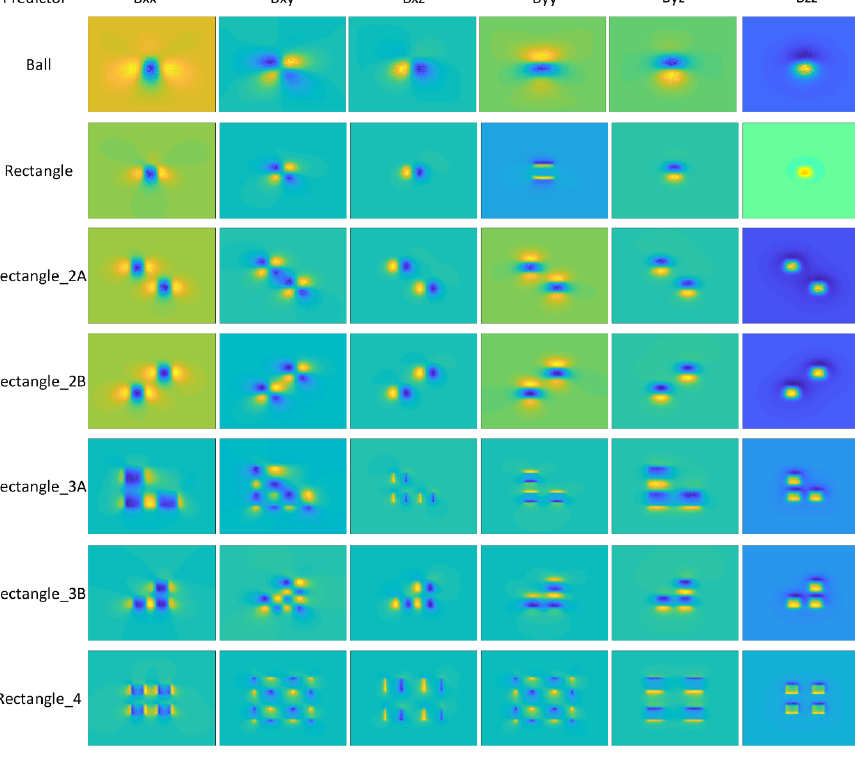
Figure 5. 2D images of seven models of MGT components.